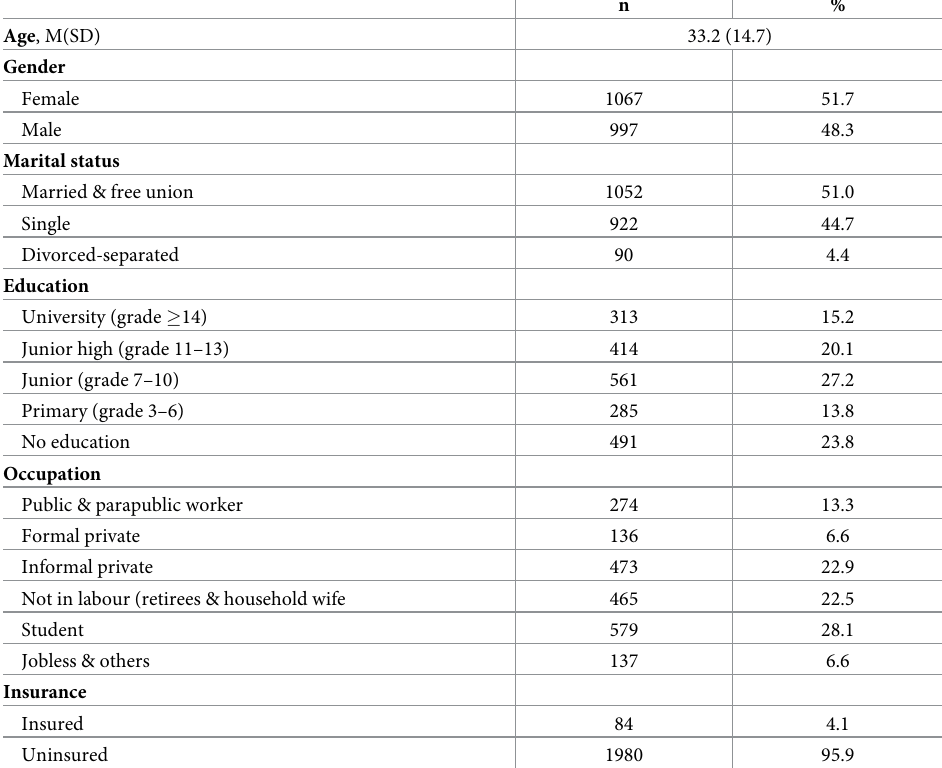
Table 1. Descriptive characteristics of the study sample (n =